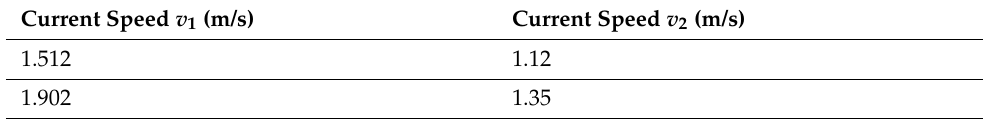
Figure 9. Current Speed (m/s) using the software. Table 7. Values of current speed before and after the